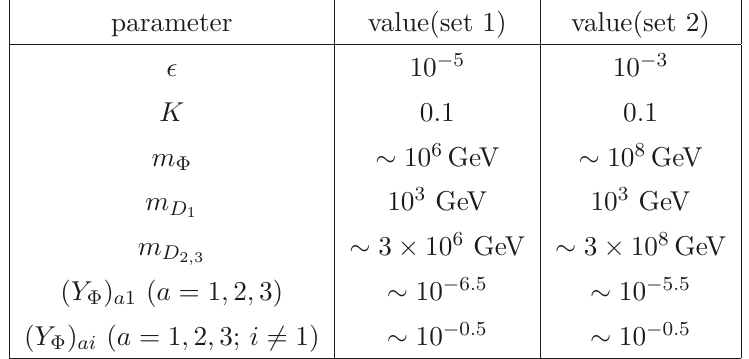
Table 2 . Two sets of benchmark parameters that satisfy all the constraints considered in the model. They cover all points in between and thus represent a broad parameter space of the